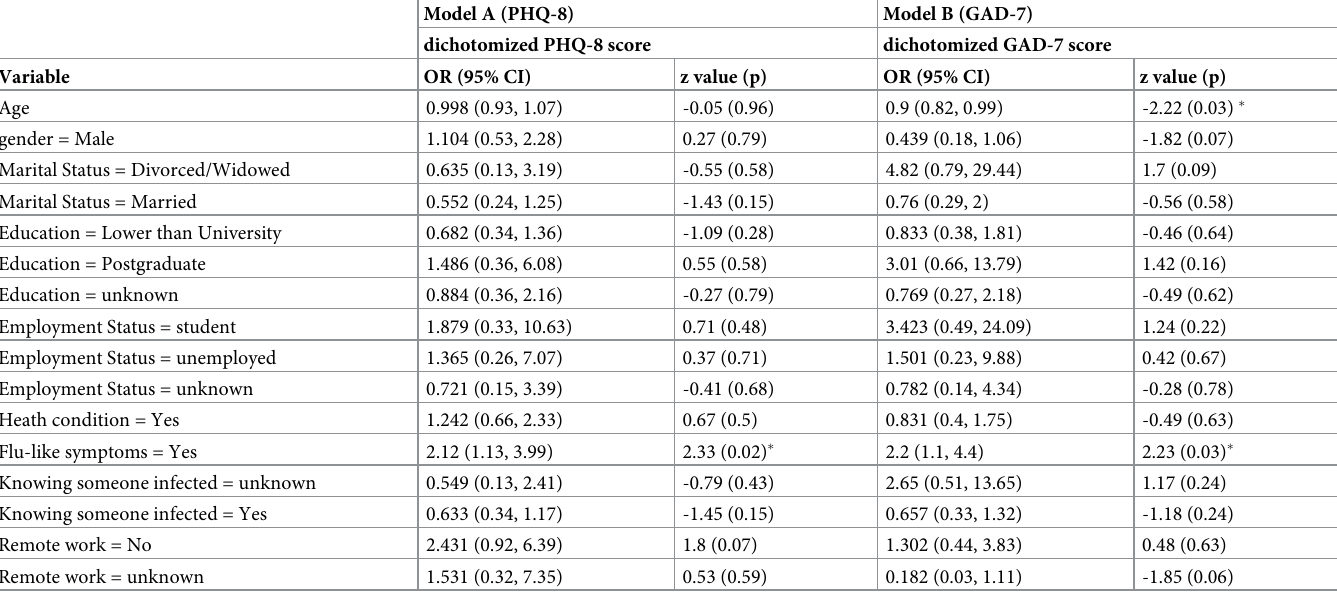
Table 3. Multivariate logistic regression models with dichotomized PHQ-8 and GAD-7 as